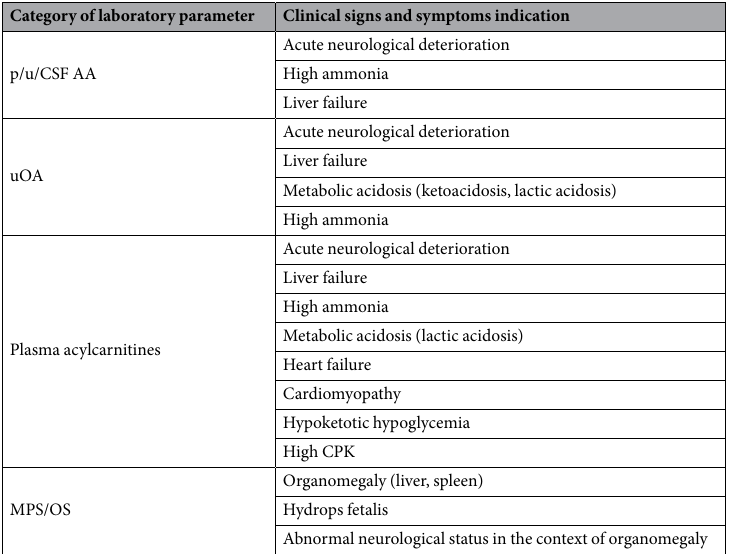
Table 1. General indication for each metabolic test. Indications for each metabolic testing. pAA: plasma aminoacid chromatography; uAA: urine aminoacid chromatography; CSFAA: cerebrospinal fluid